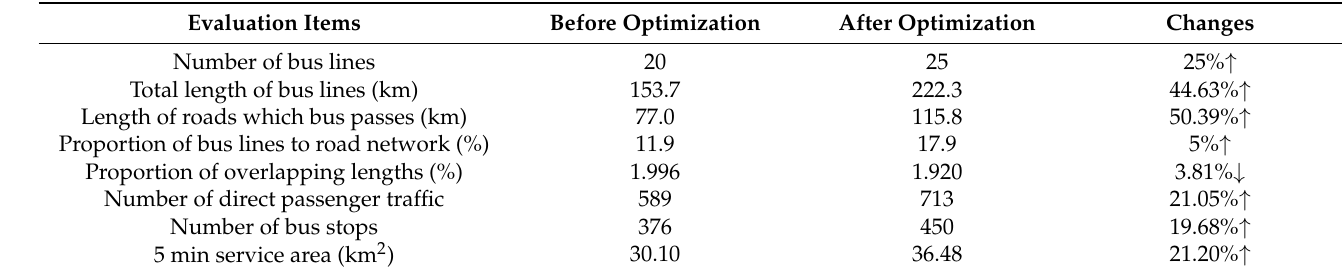
Table 1. Comparison of indicators before and after bus network